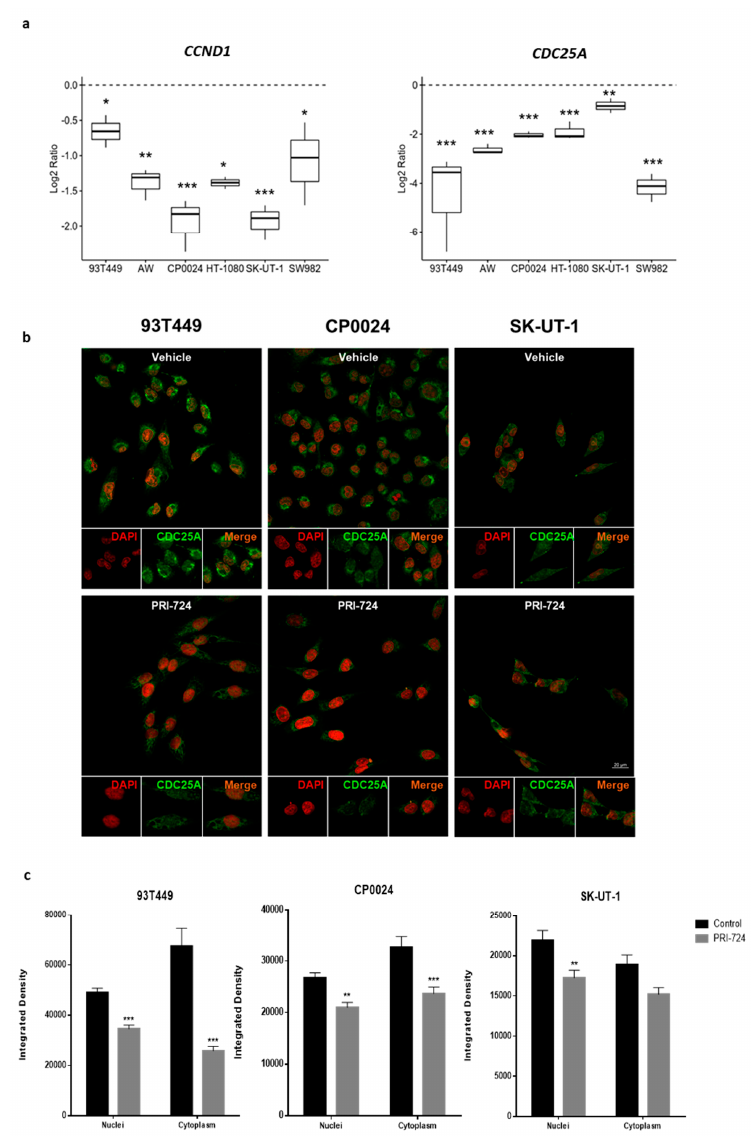
Figure 3. Inhibition of CBP / β -catenin interaction decreases the expression of TCF / β -catenin dependent target genes. ( a ) CCND1 and CDC25A mRNA expression levels in STS cells treated with PRI-724 (10 µ M) for 48 h. Each column represents means ± SEM of three independent determinations performed by duplicate. ( b ) STS cells were treated with PRI-724 (10 µM) for 48 h, fixed with methanol: acetone (1:1) and incubated with the primary antibody CDC25A (M-191) (sc-7157, Santa Cruz) followed by the addition of the secondary antibody Alexa Fluor 488 (Goat a-R A11008, Invitrogen). DAPI was added to visualize the nuclei. Panel shows representative images taken with confocal microscope, ZEISS LSM 710 (Carl Zeiss Microscope GmbH, Jena, Germany), with a 40 × objective and power of 512 × 512 pixels of at least two independent experiments performed in duplicate. ( c ) Nuclear and cytoplasmic CDC25A protein levels were quantified measuring the integrated density by ImageJ software. Each column represents mean ± SEM of two independent experiments performed in duplicate. * p < 0.05, ** p < 0.01 and *** p < 0.001 compared with vehicle-treated